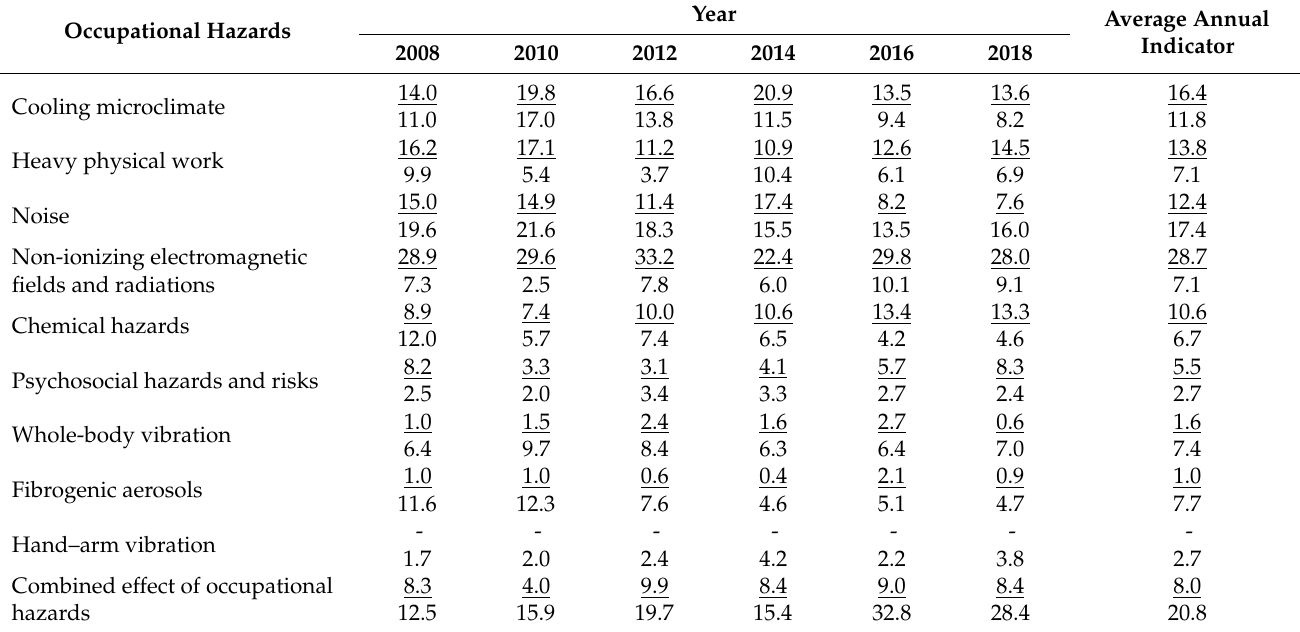
Table 1. Share of employees exposed to major occupational hazards